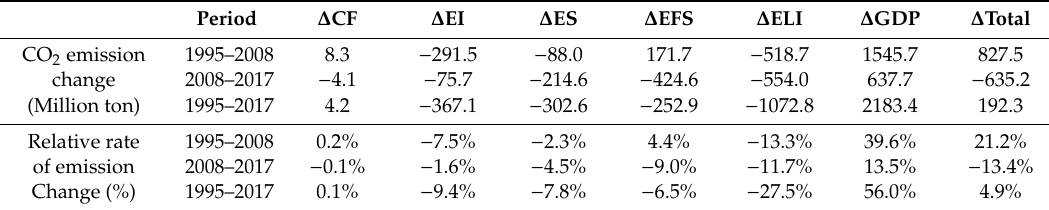
Table 3. The results of decomposition analysis of total OECD, 1995–2017 and